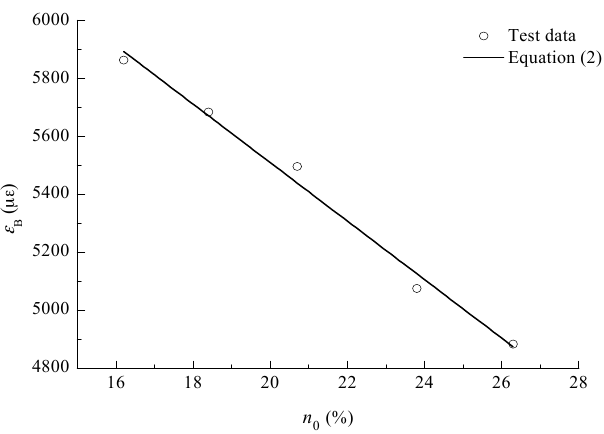
Figure 10. Relationship between maximum bending strain and